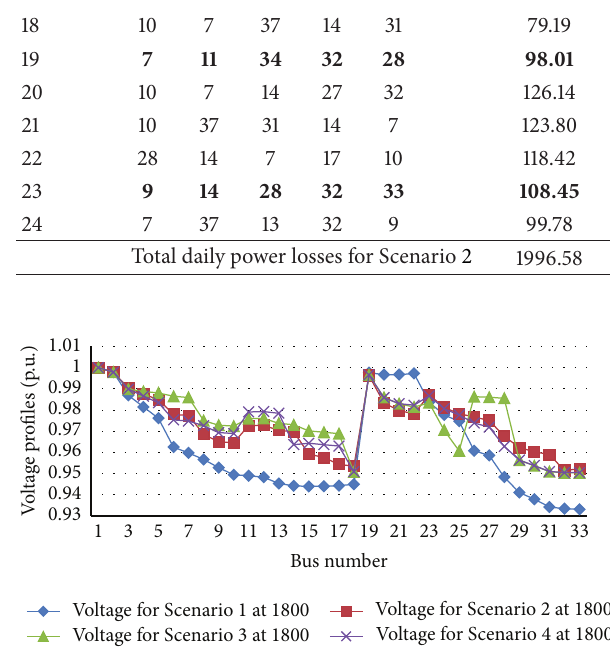
Figure 7: Voltage profiles for all buses for all scenarios with load and PV generation at 1800.